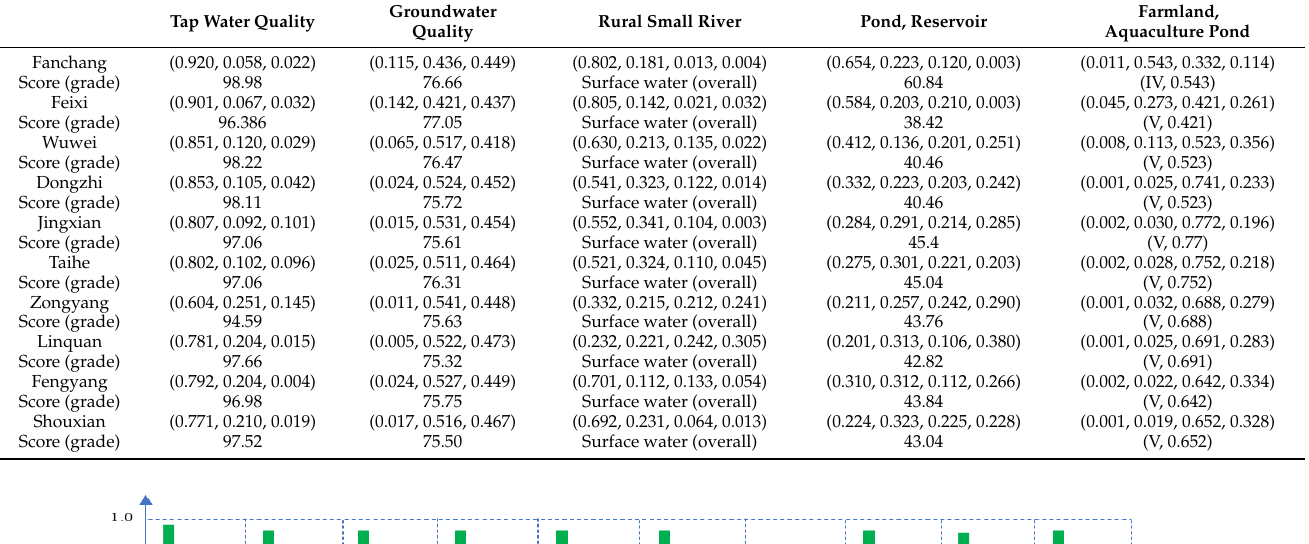
Table 5. Rural water environment quality of 10 sample counties in 2020.